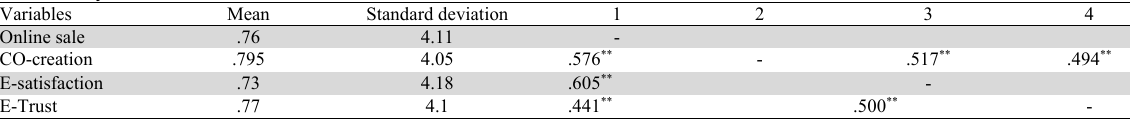
Correlativity, Mean Values, and Standard Deviations